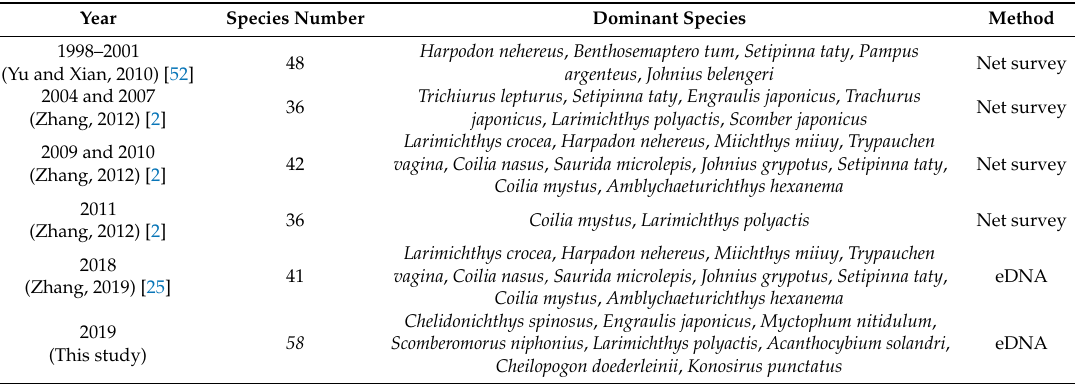
Table 3. Species composition in di ff erent